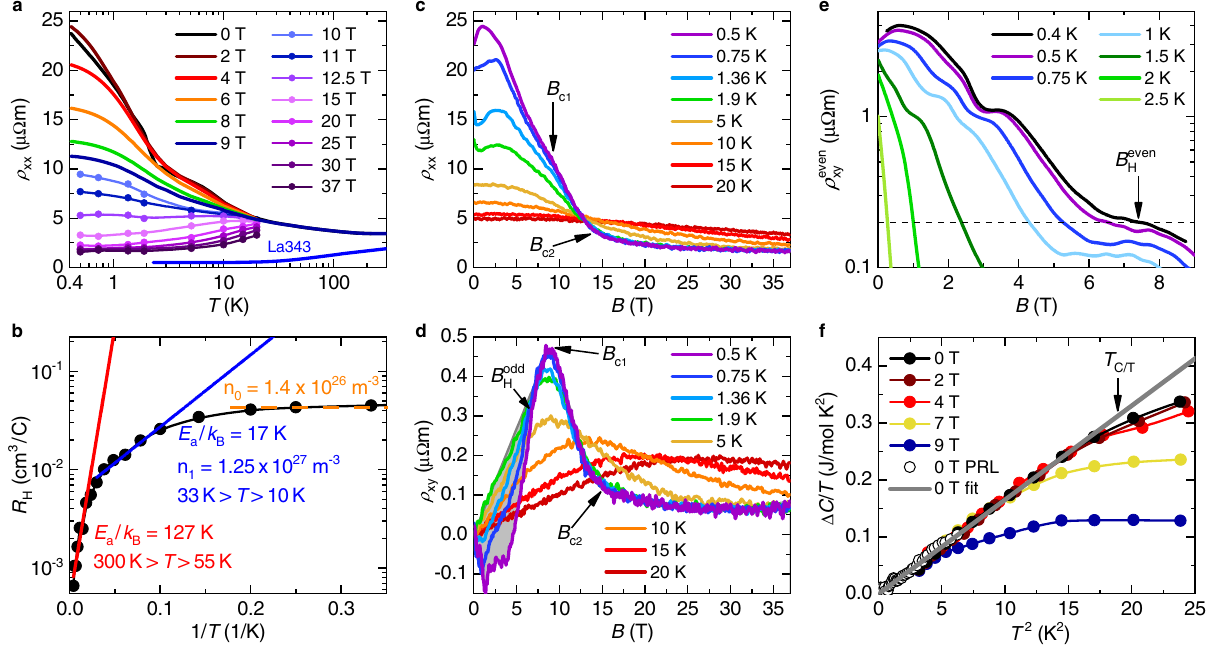
Fig. 1 | Data overview and characteristic transport and thermodynamic scales d Normal (antisymmetrized) Hall resistivity isotherms at the same fi elds and tem- of Ce 3 Bi 4 Pd 3 . a Temperature-dependent electrical resistivity at various fi xed peratures. B c1 and B c2 are determined in Fig. 2. Below B odd H (shown for the 0.5K magnetic fi elds. For B >9T, iso- B cuts (dots) were taken from panel ( c ). The zero- data),theanomalousHallcontribution(greyshading)leadstoadeviationfromthe fi eld resistivity of the nonmagnetic reference compound La initial linear-in- B normal Hall resistivity by more than 5%. e Even-in- fi eld (symme- 3 Bi 4 Pd 3 is shown for comparison. The small kink seen near 2.5K in the zero- fi eld data is associated with trized, see Supplementary Note 6) Hall resistivity isotherms at low temperatures the onset of a giant spontaneous Hall voltage that, due to the largeassociated Hall and fi elds. Above B even H (shown for the 0.4K data) this Weyl-node derived signal drops to below 0.2, which is 5% of the maximum of the lowest-temperature iso- angle, leaves an imprint also on the longitudinal resistivity 11 . The low- fi eld data are taken from Ref.11. b Arrhenius plot of the linear response normal (anti- therm (data from Ref.11). f Temperature-dependent electronic speci fi c heat coef- fi cient (see Supplementary Note 5 for details) vs T 2 at various fi xed fi elds (open symmetrized) Hall coef fi cient R H of Ce 3 Bi 4 Pd 3 (black symbols). The black line is a guidetotheeyes.Redandbluelinescorrespondto fi tswith R H = R H,i exp ½ E a = ð k B T Þ(cid:2) , symbolsare from Ref.12).Above T C/T (shown for the 0T data), the data deviate by where n i =1/( R H,i e ) isthe charge carrier concentration in a simpleone-band model. more than 5% from the low-temperature Δ C / T = Γ T 2 fi t, which represents the linear Below 10K, the data saturate to a constant value (dashed orange line), with the Weyl dispersion. The spurious low- fi eld features in the low-temperature resistivity charge carrier concentration n 0 (again in a one-band model). c Magnetoresistance isotherms (Fig. 1c) are imprints of the large Hall contributions, caused by the cur- isotherms in fi elds up to B =37T, for various temperatures between 0.5 and 20K. rent path redistribution due to the large Hall angle 11